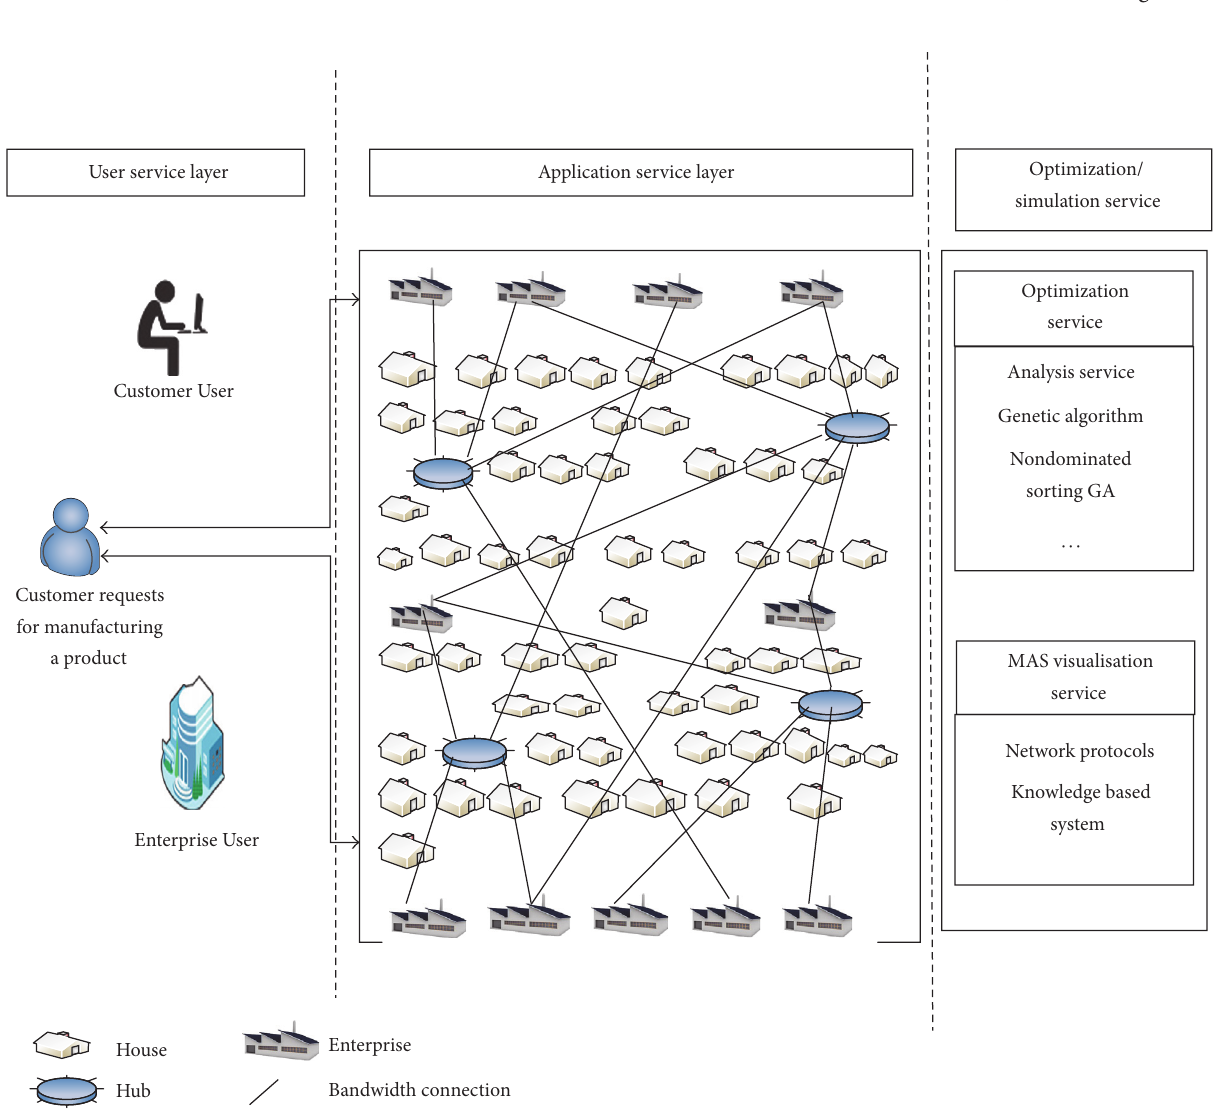
Figure 1: The framework of the proposed telefacturing